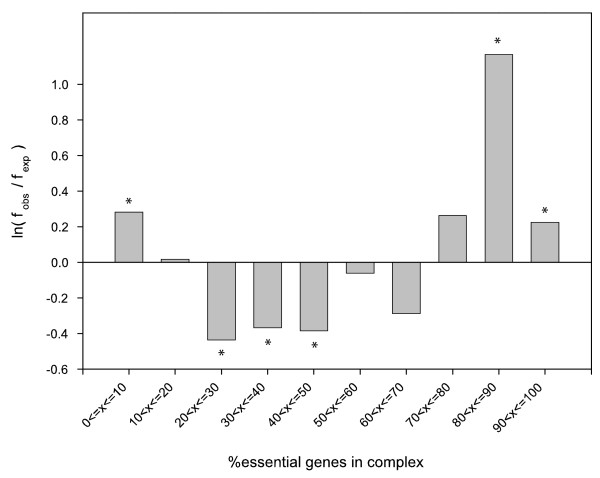
Essential proteins are concentrated in a subset of complexes. The distribution of essential proteins in complexes was compared to a randomized background. The fraction of essential proteins in each complex was calculated, sorted into equal-sized bins, and compared to an expected background generated by randomly assigning essential proteins to the same set of complexes. The log ratio of observed to expected frequency for each bin is plotted here: positive values indicate observed frequency above random; negatives indicate below random. The distribution illustrates the concentration of essential proteins in some complexes, and a corresponding absence of essentials in others. Bars marked with an asterisk represent statistically significant deviations from random expectation (P <10-3).